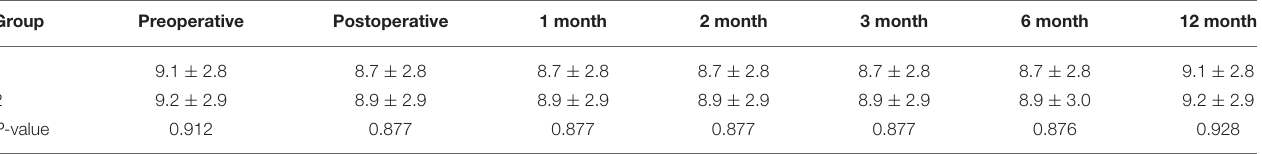
TABLE 6 | Cobb angle of the two groups ( ◦